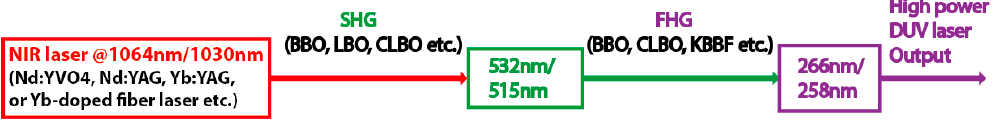
Figure 1. Schematic setup of the solid-state DUV laser by FHG of 1- μ m laser (DUV: deep ultra-violet; SHG: second-harmonics generation; FHG: fourth-harmonics generation; YAG:Y 3 Al 5 O 12 ; BBO: β -BaB 2 O 4 ; LBO: LiB 3 O 5 ; CLBO: CsLiB 6 O 10 ; KBBF: KBe 2 BO 3 F 2 ).